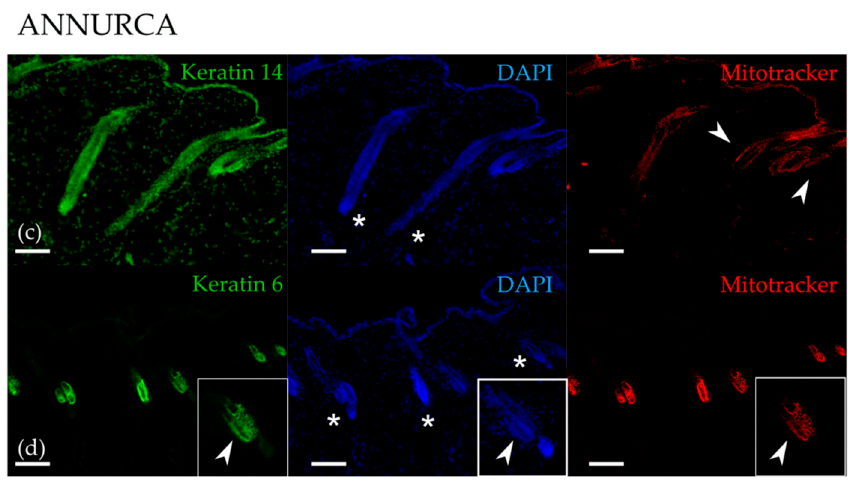
Figure 3. AAE increases mitochondrial membrane potential in murine HFs. Skin biopsies collected from mice treated with AAE or placebo foam were incubated ex-vivo with Mitotracker CMX-ROS. UPPER PANEL: A faint fluorescence emission of the probe (red channel) is detectable in Keratin 14 positive and Keratin 6 HF cells (green channel) in placebo biopsies. LOWER PANEL: Increased fluorescence emission of Mitotracker CMX-ROS in Keratin 14 and Keratin 6 positive HF cells and hair bulges of mice treated with AAE. Asterisks indicate HFs. Arrows indicate bulge regions. Scale bars correspond to 200 μ m in ( a ), ( c ) and ( d ), 50 μ m in ( b ).